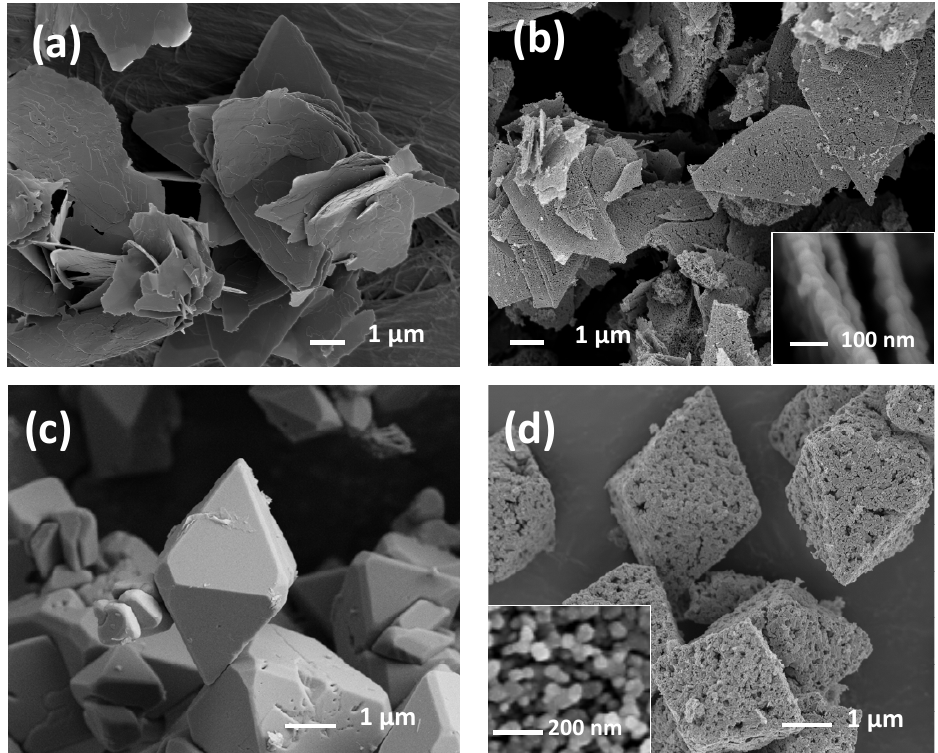
Figure 2. FE-SEM images of leaves precursor ( a ), leaves ( b ), bisphenoids precursor ( c ), and bisphenoids ( d ).